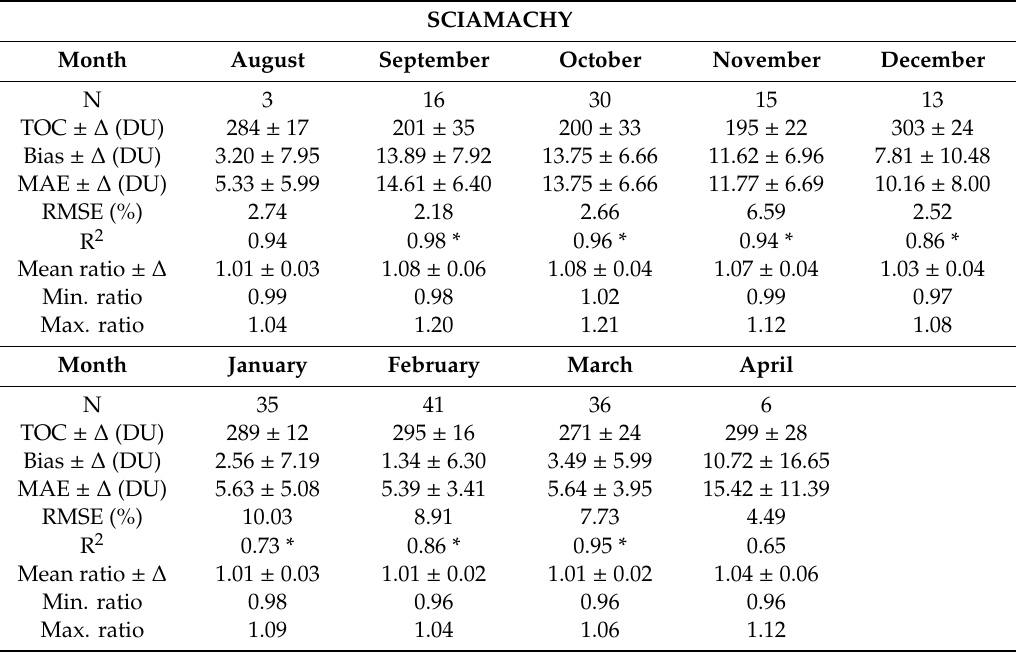
Table A6. Monthly statistics derived for individual data sources (asterisks indicate statistically significant ( α = 0.05)